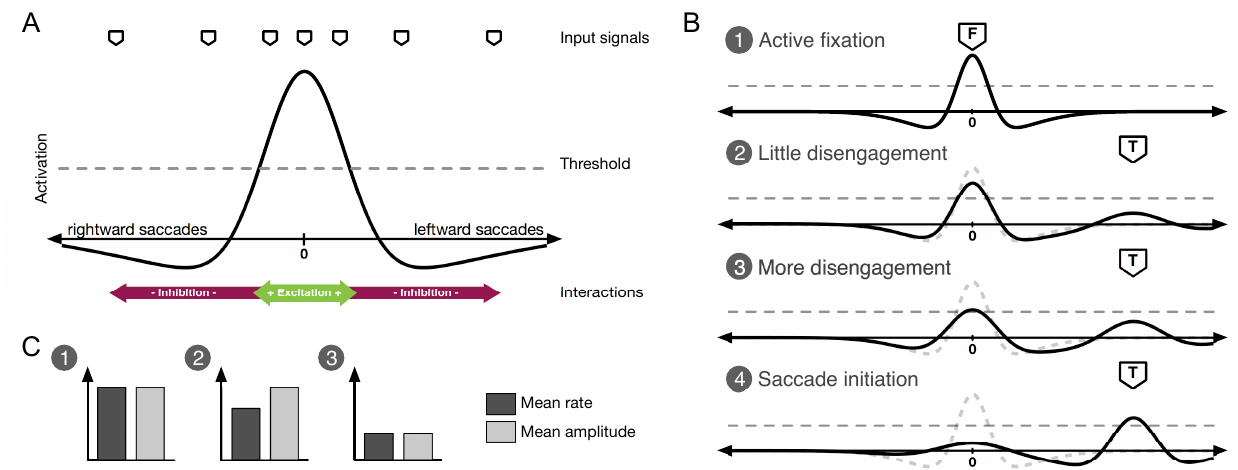
Figure 1 . Schematic outline and predictions of the common-field model of microsaccade and saccade generation as proposed by Rolfs et al. (2008). Microsaccade statistics are the result of the average distribution of suprathreshold activity at the central part of a saccadic motor map. The amount of this activity mediates microsaccade rate. The generated microsaccade-amplitude distribution covers the range of amplitudes in the field that exhibit suprathreshold activation. Note that the characteristics of a particular microsaccadic event are determined by the current distribution of activity in the map, which is strongly influenced by noise. A Model outline showing an average distribution of activity during visual fixation. Incoming input signals modulate activity in the map. Its internal dynamics are shaped by local excitation and global inhibition mechanisms. B Changes of ac- tivity in the map during saccade preparation. Activity distributions 1 through 4 illustrate fixational disengagement as saccade preparation progresses. Dashed gray lines in 2, 3, and 4 display the distribution during active fixation (1). C Predictions for microsaccade rate and amplitude for activity distributions 1, 2 and 3 of panel B. Fixational disengagement results in fewer microsaccades with smaller mean